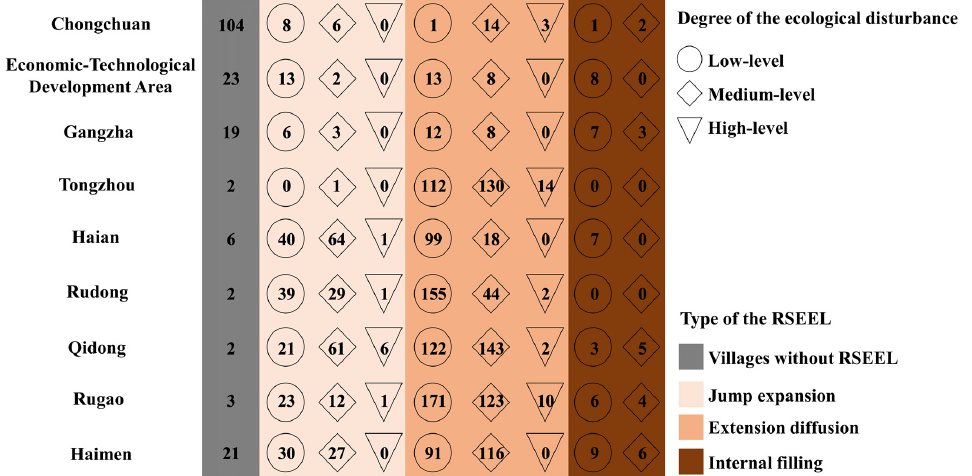
Figure 9. Correlation patterns of encroachment type and degree of ecological disturbance in RSEEL at the county level. Table 1. Cross-analysis of encroachment type and degree of ecological disturbance in RSEEL in Nantong.